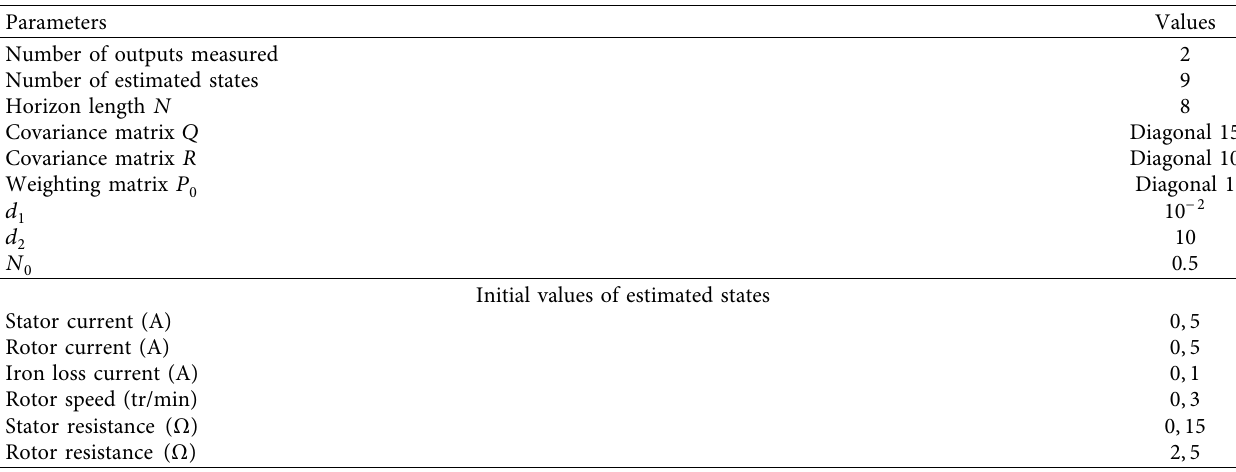
Table 2: Estimator